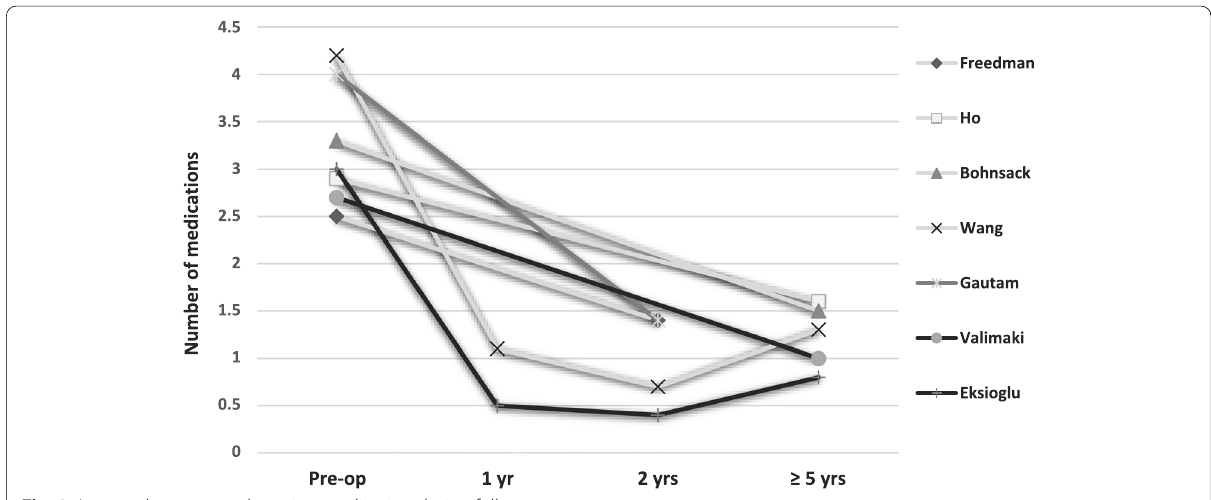
Fig. 3 Intraocular pressure- lowering medication during follow-up